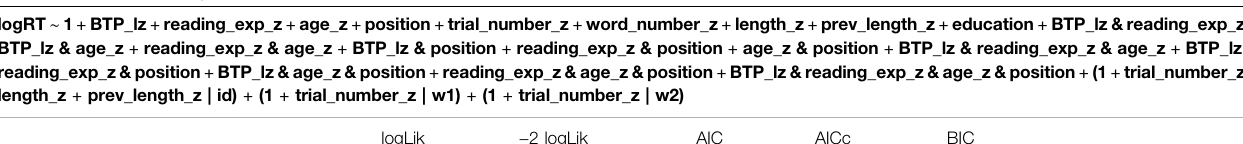
TABLE 3 | Model output linear mixed effects model with backward transition probability. Linear mixed model fi t by maximum